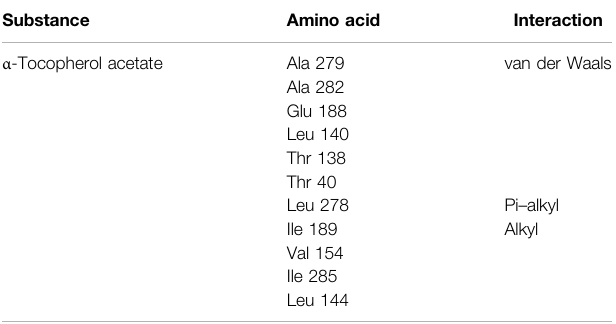
TABLE 6 | Amino acids and interactions type around the corresponding tunnel (tunnel 2) and ligand ( α -tocopherol acetate).